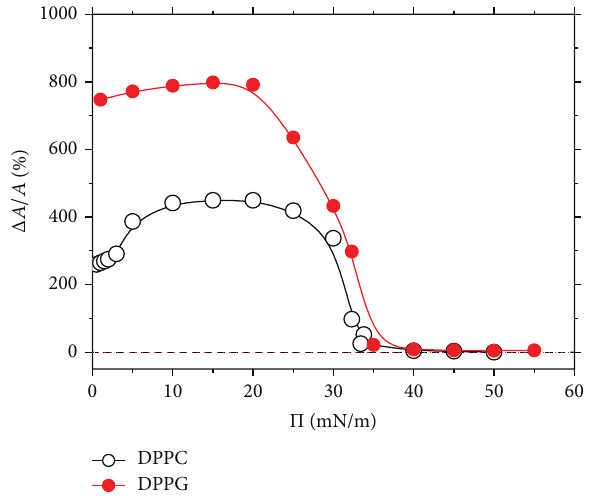
Figure 2: Effects of expanding DPPC and DPPG monolayers by lactophoricin-I (N-23-T). The Δ𝐴/𝐴 (%) denotes the relative increase of area per the phospholipid molecule due to the peptide’s penetration. It is evaluated (with the accuracy below 2%) by comparing the Π - 𝐴 isotherms presented in Figures 1(a) and 1(b) at the same Π and plotted as a function of the Π . The peptide’s concentration is 1 𝜇